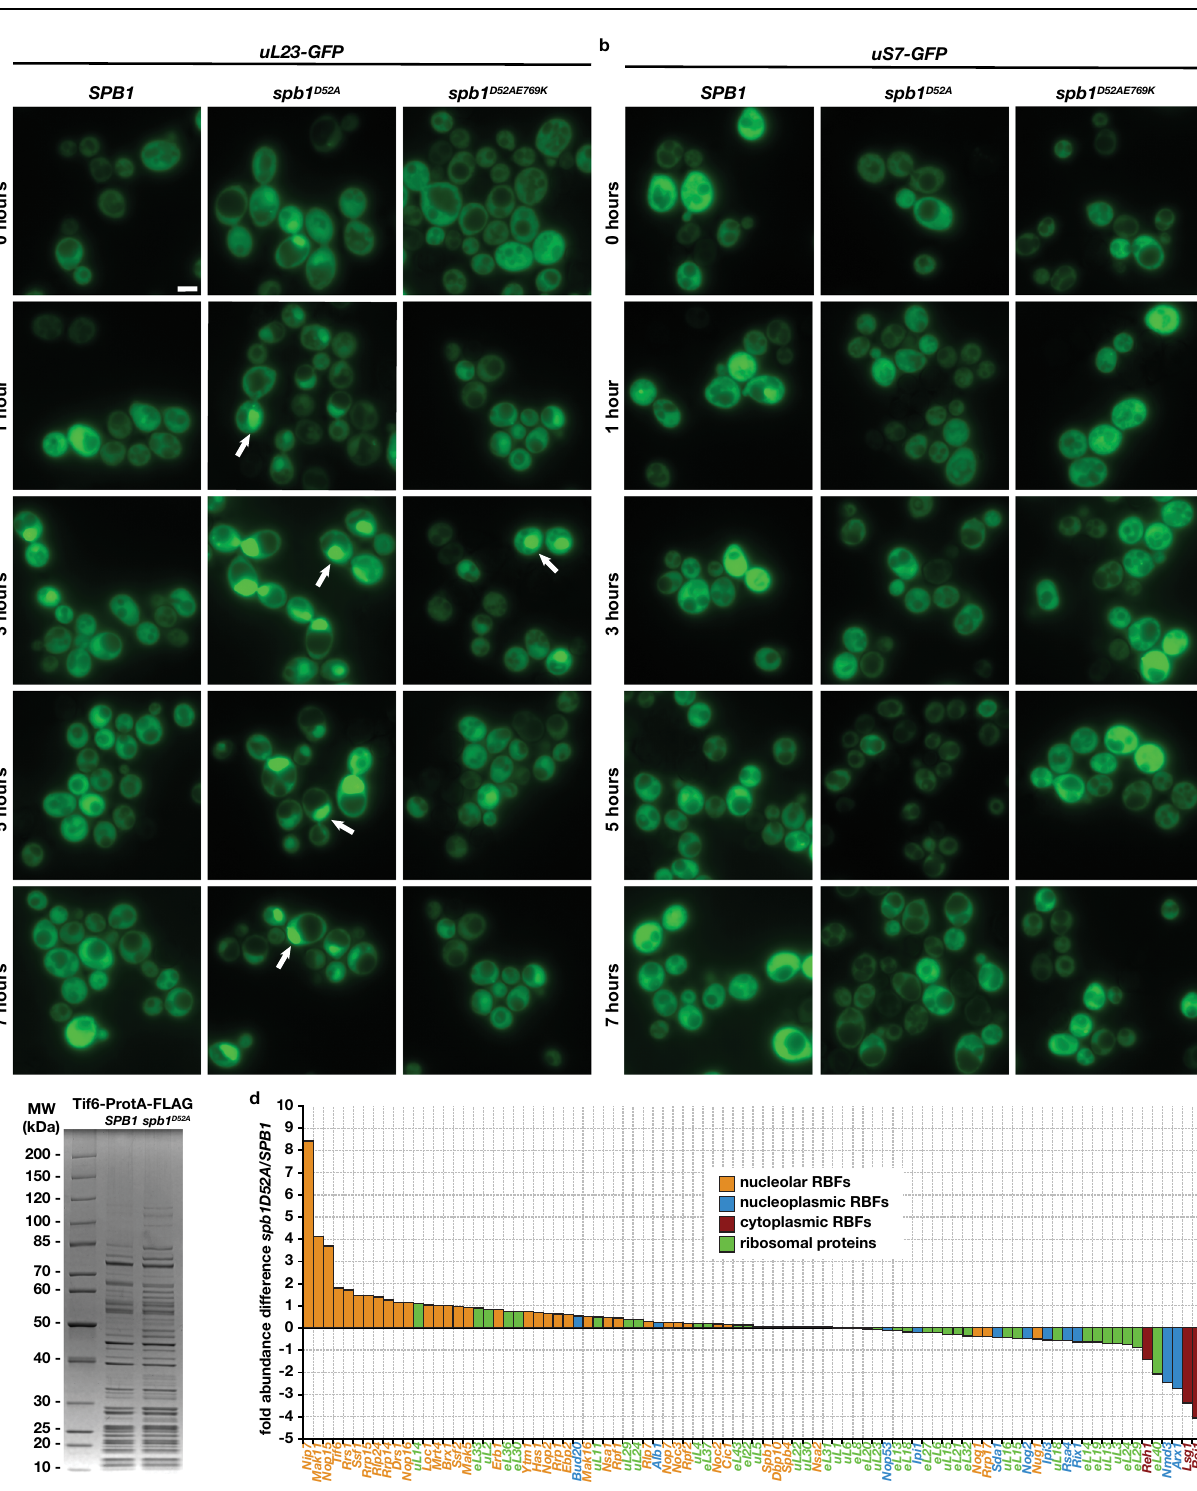
semi-quantitative mass spectrometry. d Visualization of semi-quantitative mass- spectrometry data sorted by differences in abundance between spb1 D52A and SPB1 strains using representative RBFs and RPs between the two samples. RBFs are colored according to the subcellular compartment where they fi rst bind pre-60S intermediates, showing a clear trend of nucleolar RBFs enrichment and late nucleoplasmic and cytoplasmic RBFs reduction. RP abundances are shown in